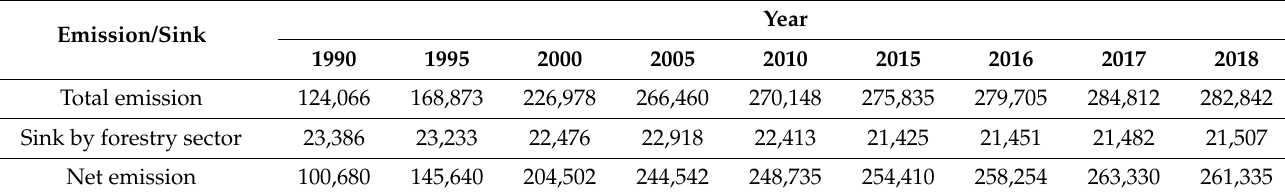
Table 4. Taiwan’s carbon dioxide emissions and sinks 1